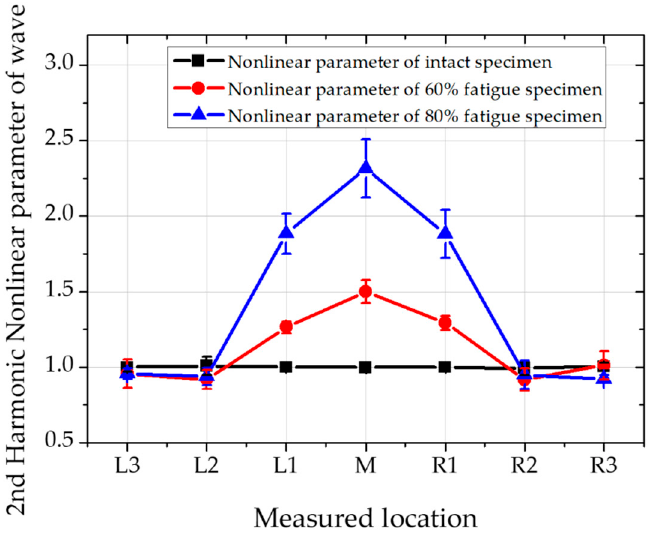
Figure 8. Second harmonic wave for measuring nonlinear parameter at various positions.